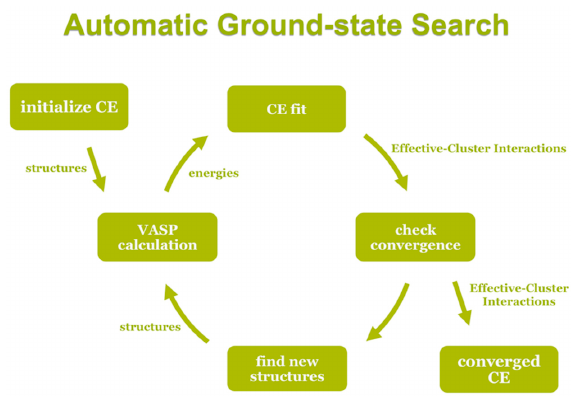
Figure 12. Schematic description of the cluster expansion ground ‐ state search.